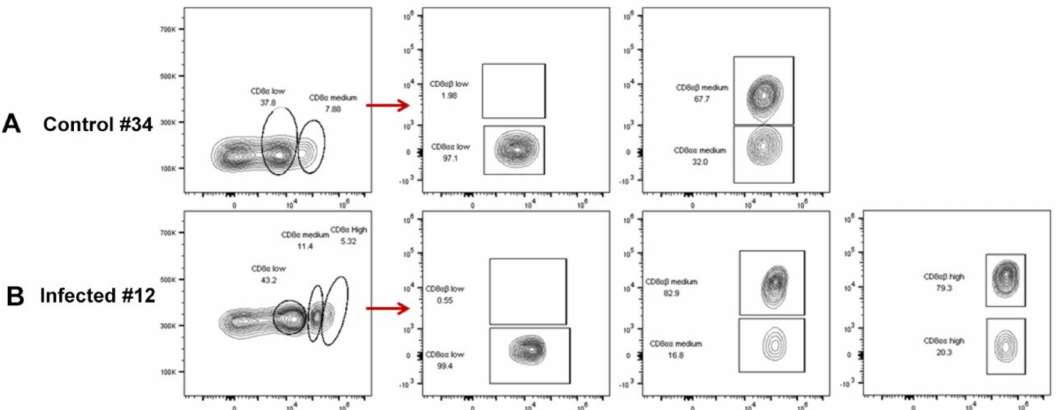
Figure 8. CD8 + T cell phenotype analysis. Contour plot of CD8 + αα and CD8 + αβ T cells in PBL of ( A ) control chicken number 34 and ( B ) ALV-J infected chicken number 12 with the CD3 + (APC), CD8 β + (FITC), and CD8 α + (PE) antibodies. Each sample collected 1 × 10 5 cells for flow cytometric analysis. The circle or fame indicated the gated target cell population labelled by various antibodies. And the red arrow indicated that each CD8 α + T cell population was further subdivided to CD8 αα and CD8 αβ